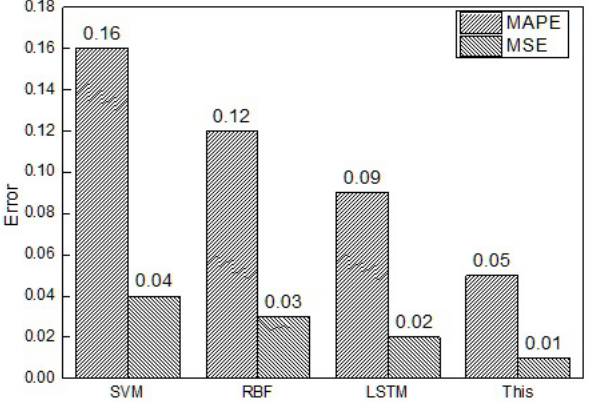
Fig. 9 Error comparison of different prediction